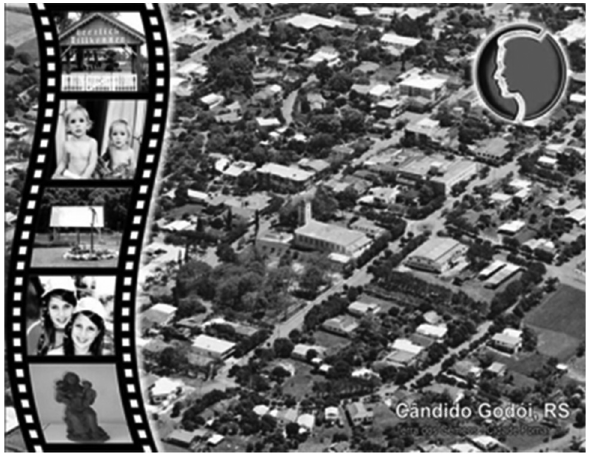
Figure 3 - Sign in CG showing its own recognition as a “Twin Town”. Source: Prefeitura Municipal de Candido